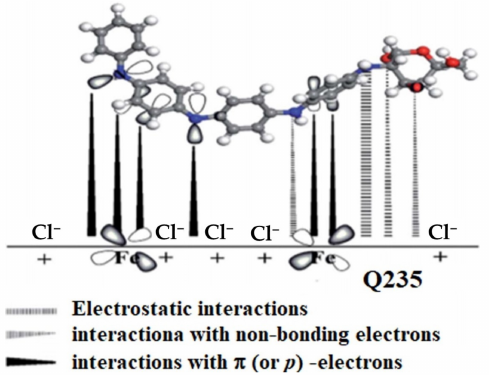
Figure 2. Schematic illustration for the protective effect of polymeric inhibitor on steel sheet in corrosive medium [7]. Reproduced with permission from ref. [7]. Copyright 2022